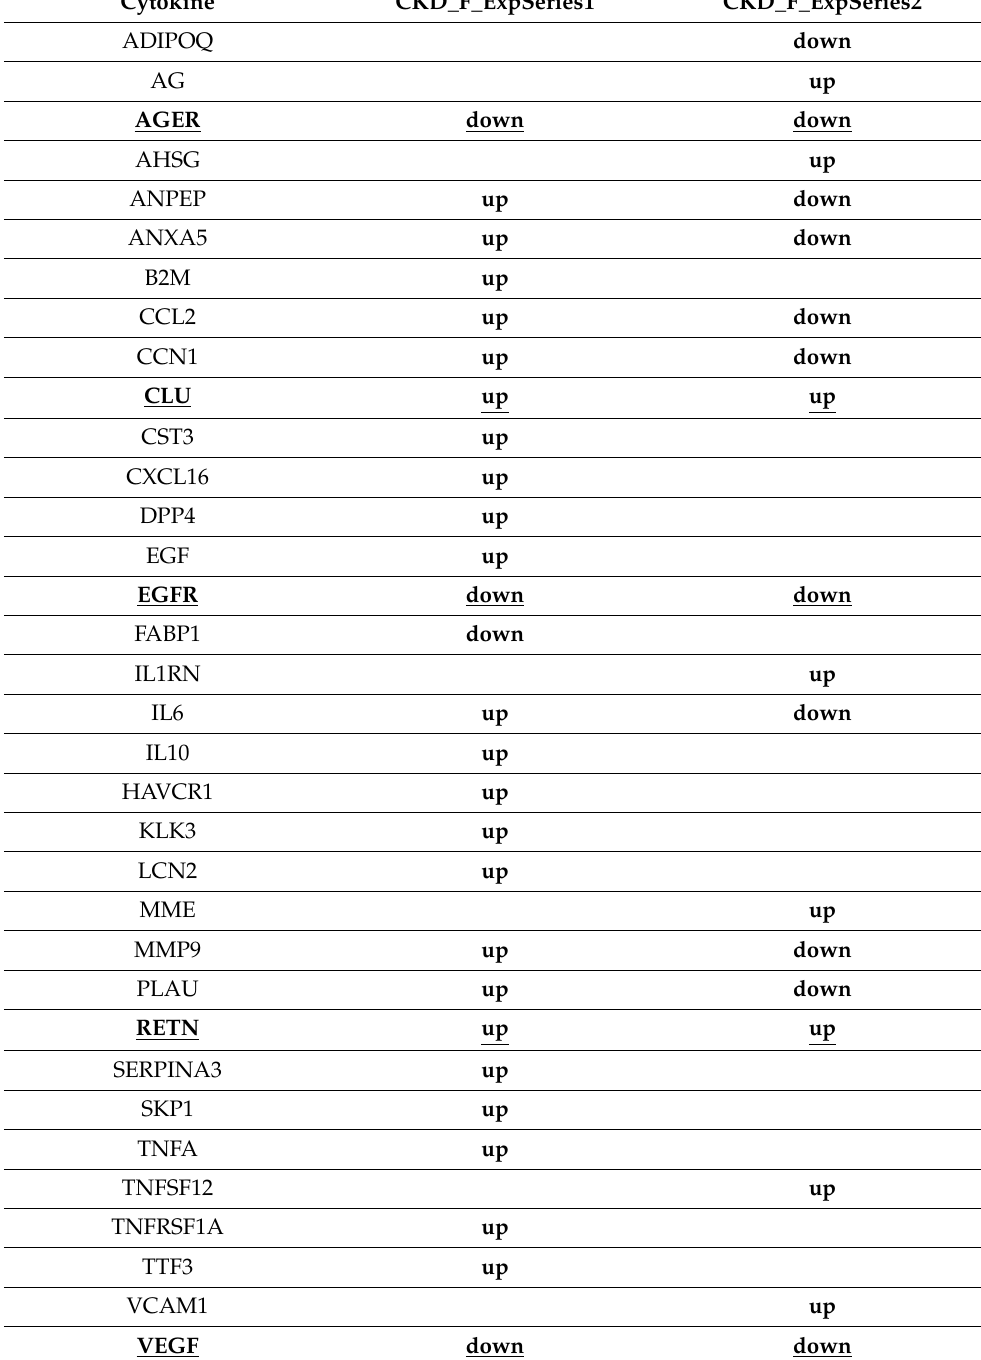
Table 3. CKD markers identified in female CKD patients in experiment series 1 and